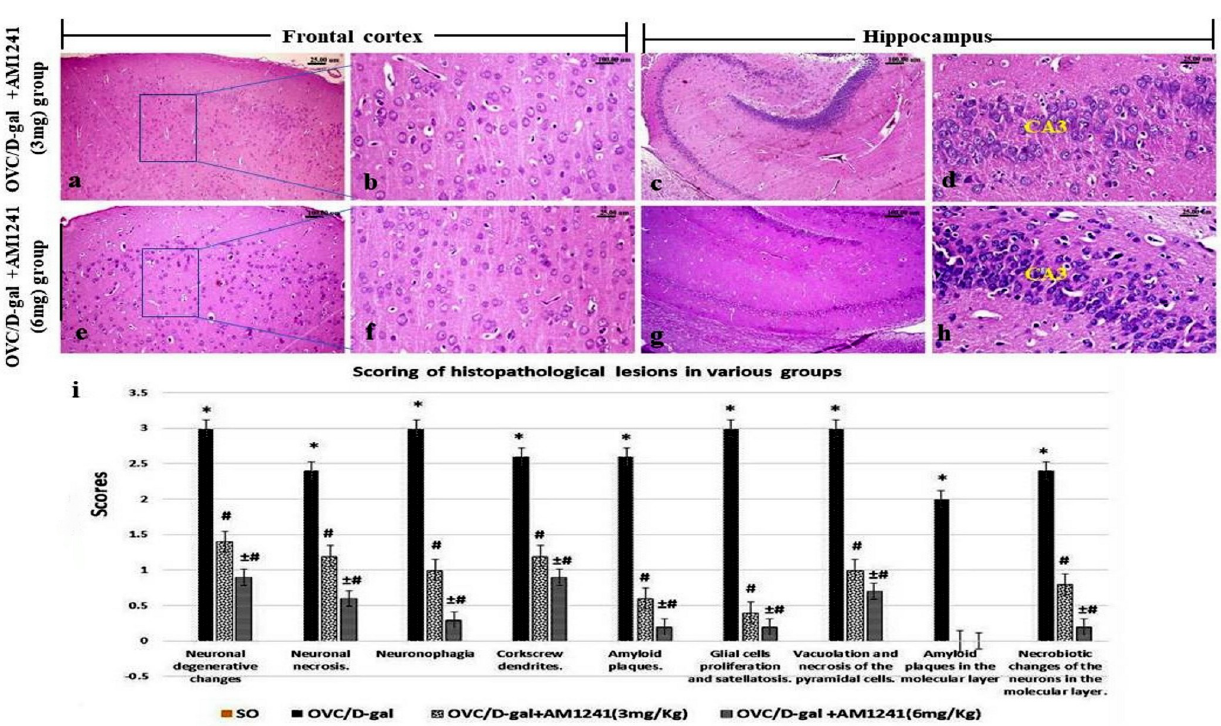
Fig 5. H&E stained photomicrographs of frontal cortex and hippocampus areas of AD-model rats which treated with AM1241, (a-d) 3mg/kg and (e-h) 6mg/kg showing; few cerebral cortical scattered degenerated and necrotic neurons, absence of amyloid plaques with hippocampal disappearance of the amyloid plaques, mild degenerative changes of the DG and CA neurons. (i) The scoring of the observed histopathological lesions in various groups (Data are presented as median (n = 5 rats/group) using Kruskel-Wallis test followed the Mann-Whitney U test. Significantly different was considered at P < 0.05, where; � significantly different when compared to control group, # significantly different when compared to OVC/D-gal group, ± significantly different when compared to AM1241